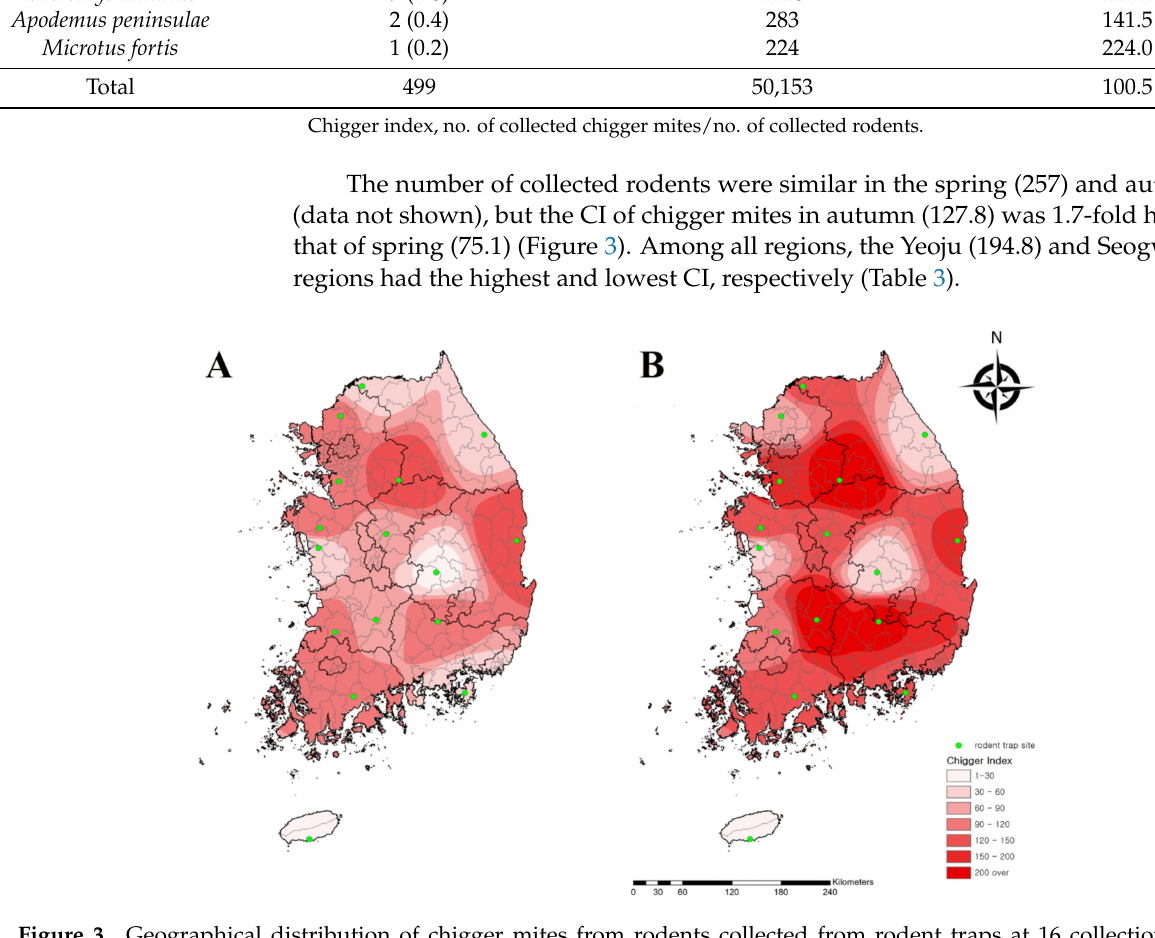
Figure 3. Geographical distribution of chigger mites from rodents collected from rodent traps at 16 collection sites nationwide in the ( A ) spring and ( B ) autumn in the Republic of Korea in 2020. The map color indicates the chigger index (0 to >200). Rodent traps are denoted by green dots. The chigger index shows the number of chigger mites per